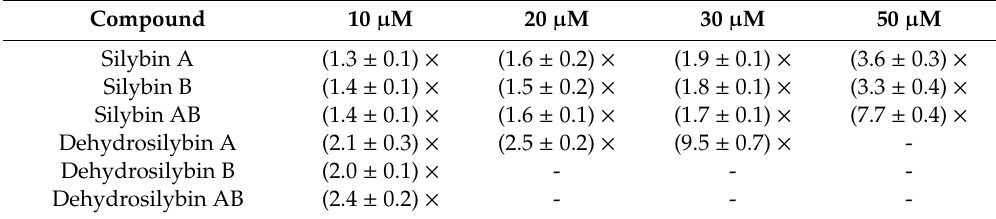
Table 9. Doxorubicin-sensitization rate of silybin and dehydrosilybin isomers in A2780 / DOX cell line.